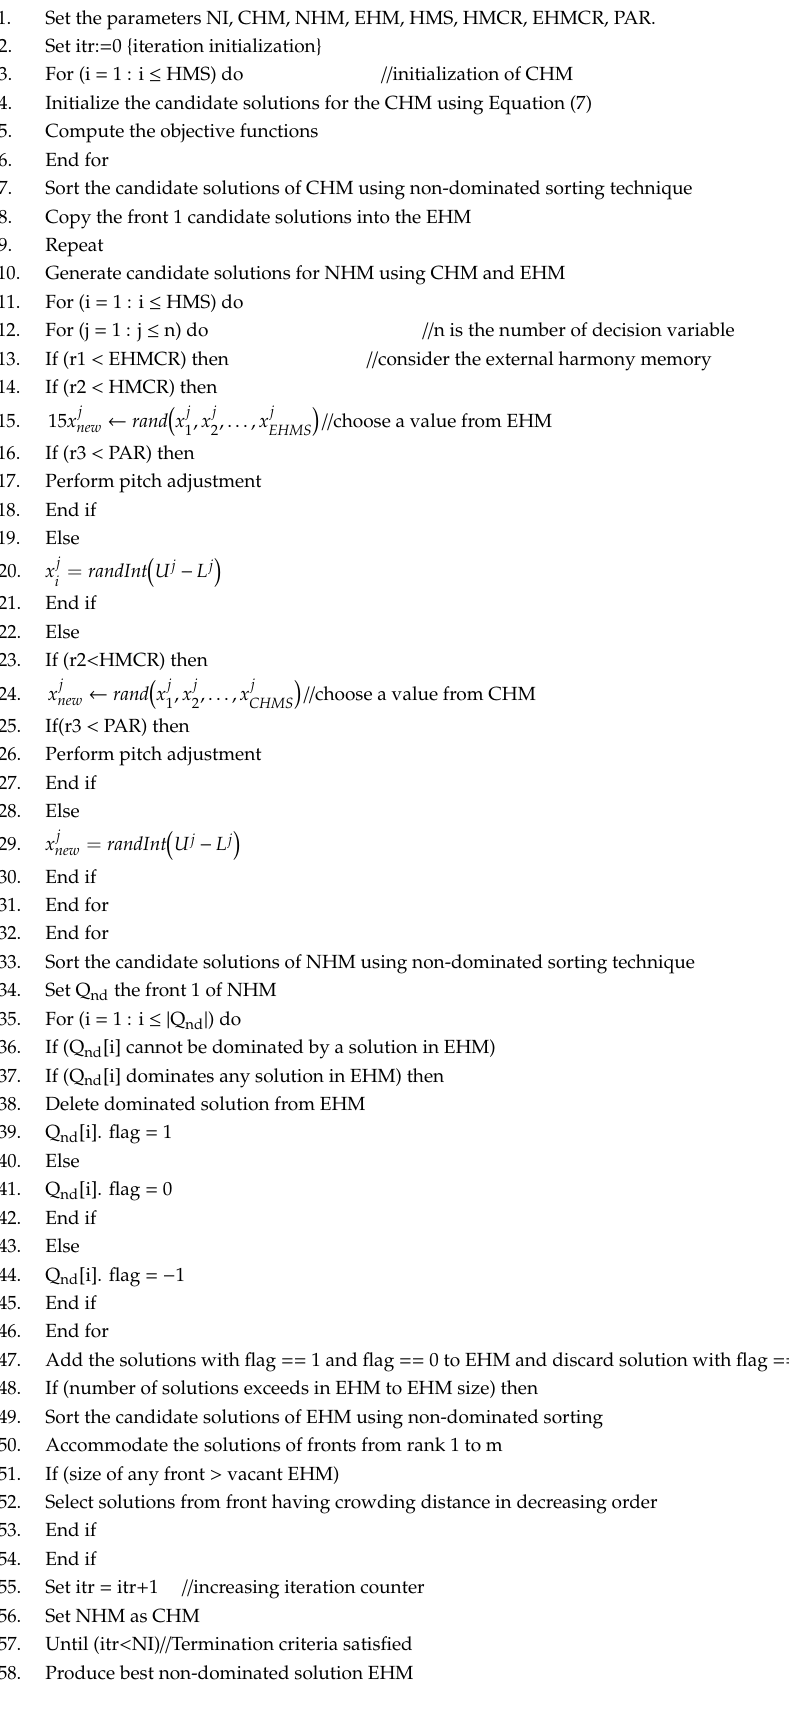
Algorithm 1 MoHS-SAR